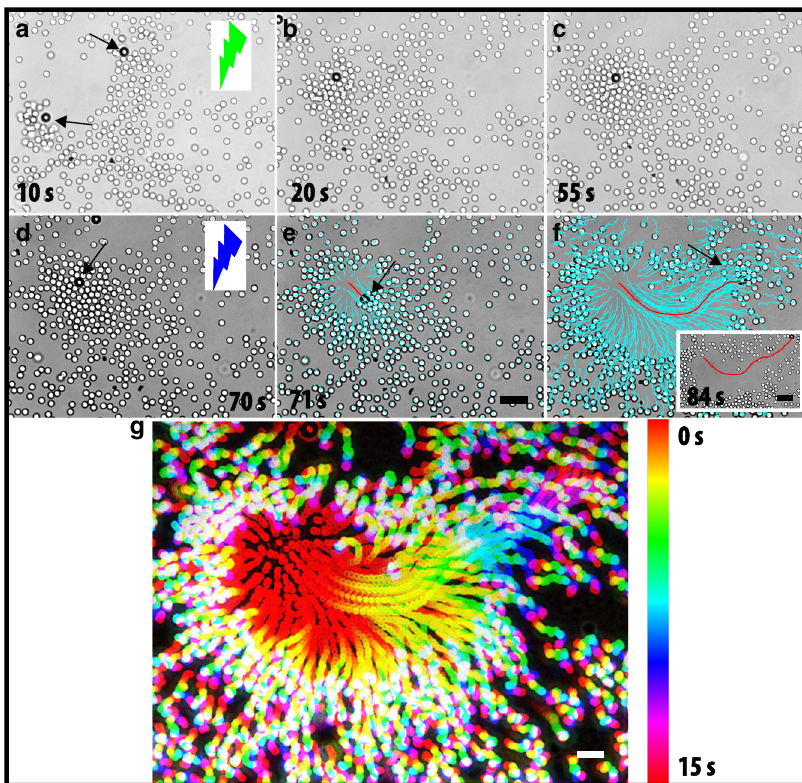
Fig. 4 Switchable photoresponsive colloidal particles in a sea of passive particles: from pulling to pushing. a – c Assembly: Sequence of time-lapsed images show fi rst the dynamic clustering of passive particles around the active particle under the green light illumination. d – f Disassembly: Sequence of time-lapsed images obtained upon the switching of the illumination to UV light. Overlaid trajectories reveal the outward motion of the passive particles. Inset f , overlaid trajectory shows the active particle motion. Cyan colour corresponds to the trajectory of the passive particles the red colour represents the active one. The black arrow depicts the position of the active particle. Colour of the lightning bolt represents the wavelength of light used in the experiment, respectively. g Time-stamped trajectories show motion of passive particles under UV light illumination. Scale bar is 5.0 μ m. Scale bar in the inset is 10.0 μ